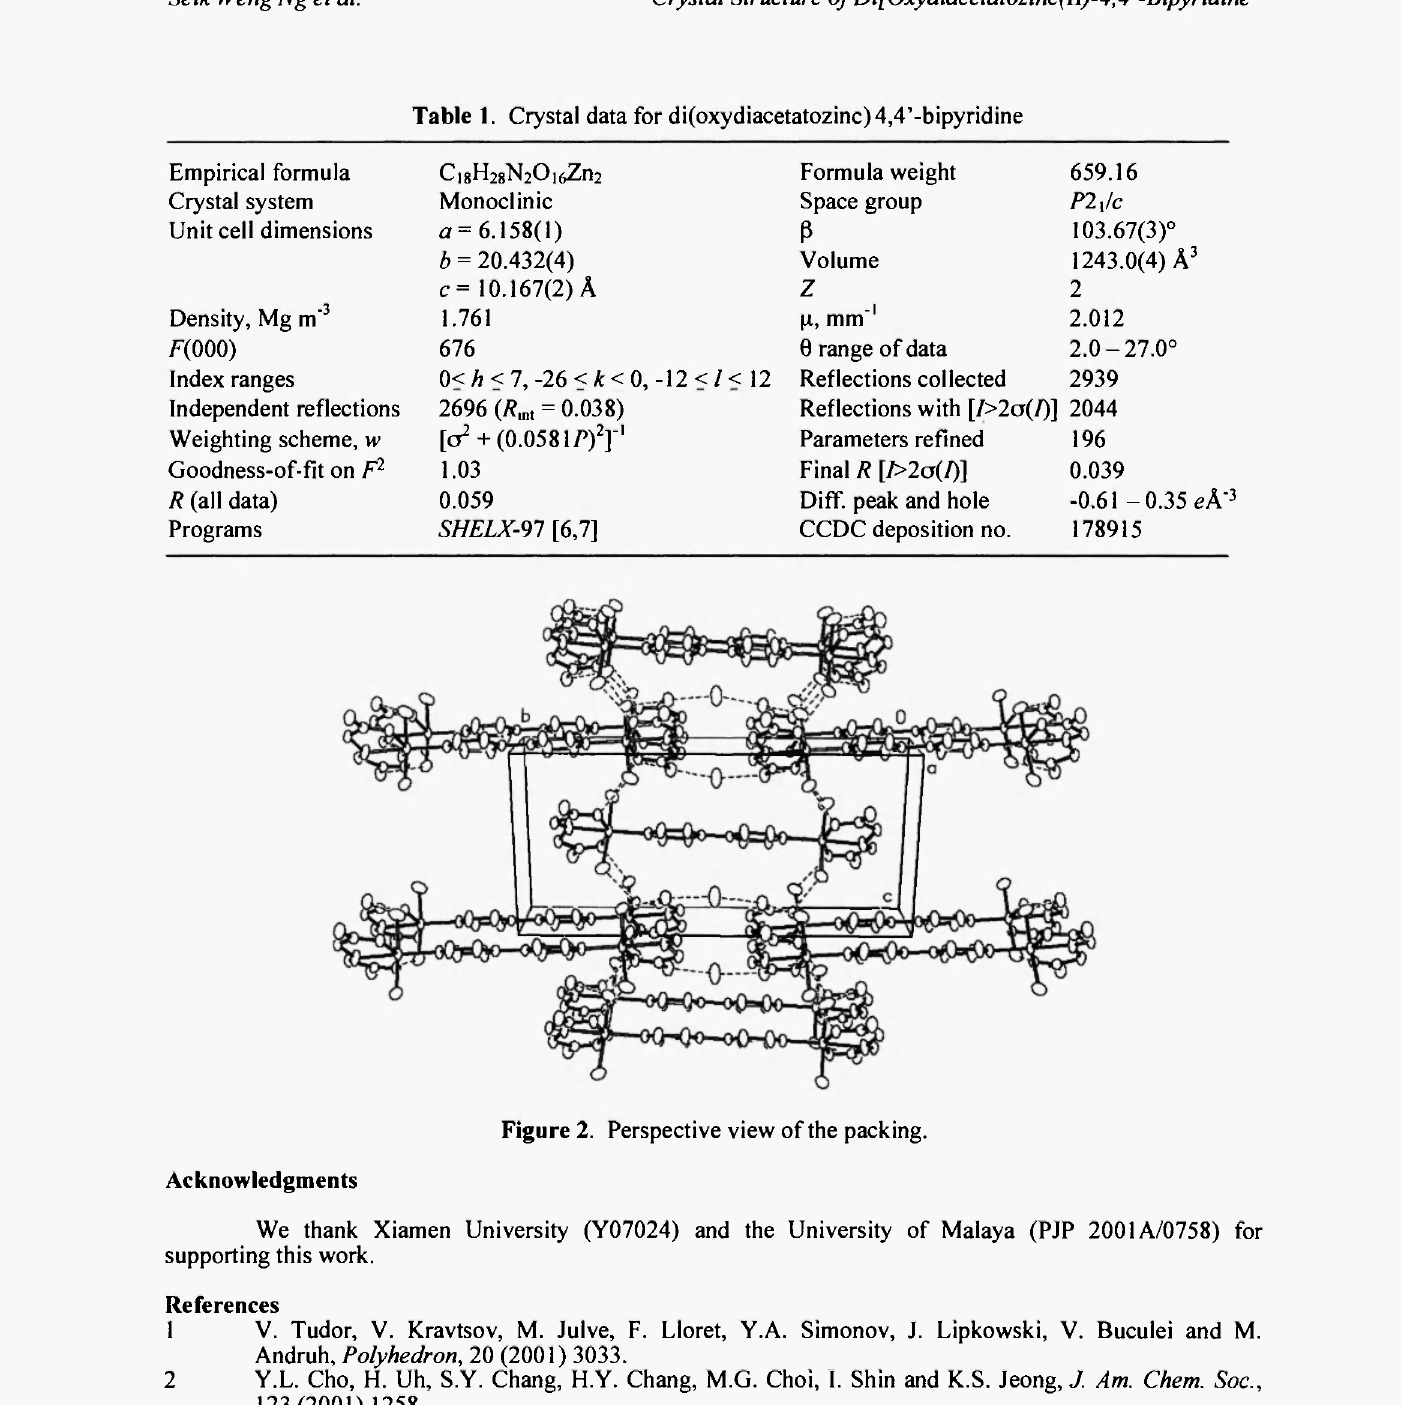
Table 1. Crystal data for di(oxydiacetatozinc)4,4'-bipyridine